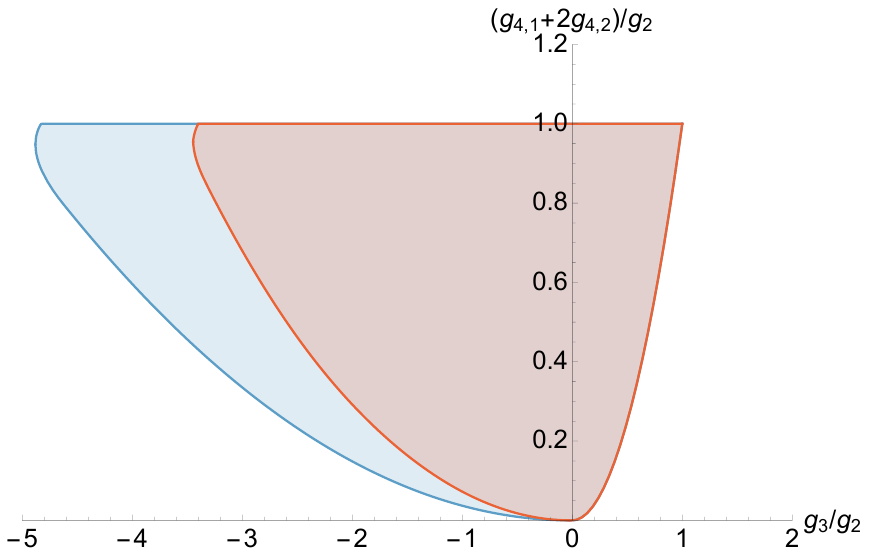
e 1 = g 3 , g 2 e 2 = g 4 , 1 + 2 g 4 , 2 normalized to g 2 . The blue, M 2 M 4 = 0 , ± 1 . Intermediate allowed regions can be obtained by linear 2 /g 2